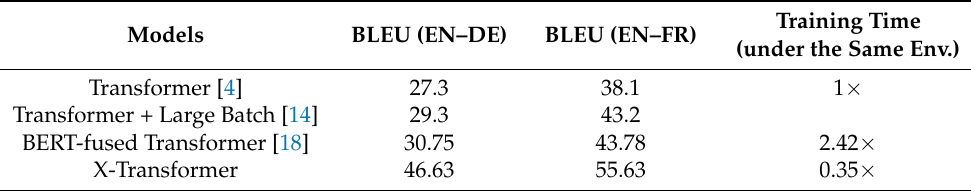
Training Time (under the Same Env.)